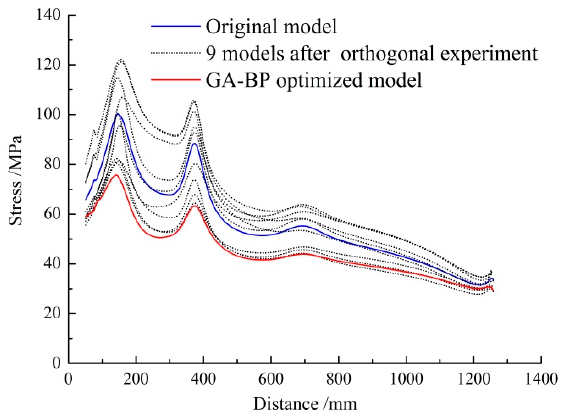
Figure 10. Stress distribution curve before and after optimization.